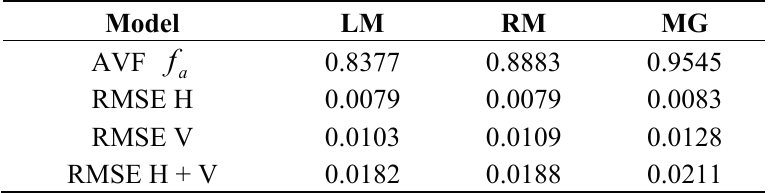
Table 1. RMSE between experimental and theoretical emissivities for H and V f of the foam polarizations, and the tuning AVF a